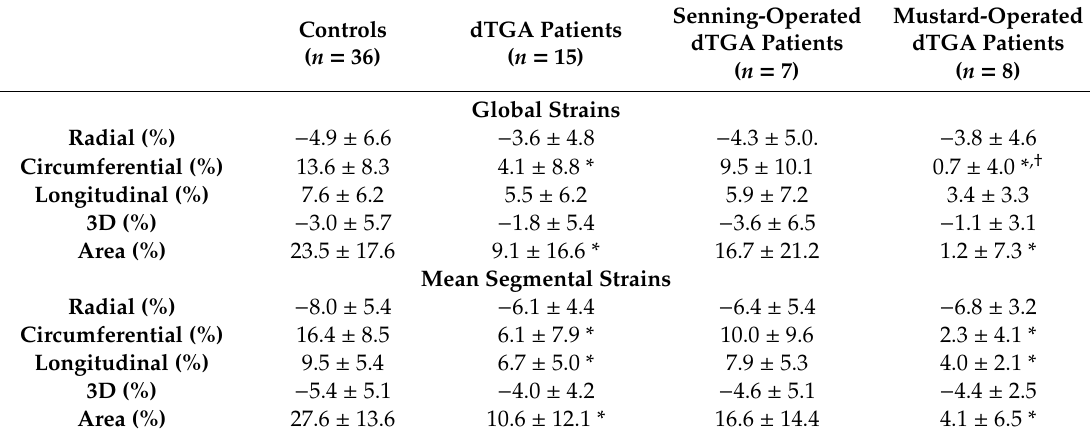
Table 5. Comparison of three-dimensional speckle-tracking echocardiography-derived regional left atrial strains at atrial contraction of patients with dextro-transposition of the great arteries and those of